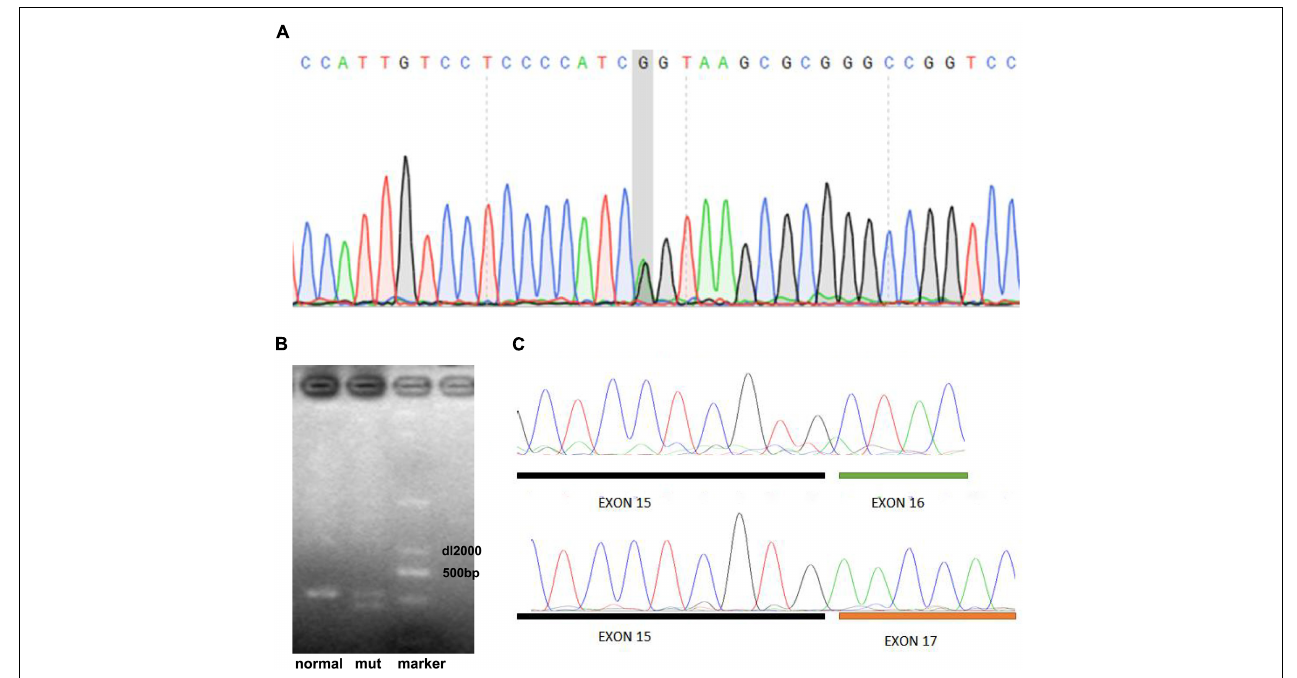
FIGURE 2 | Identification of genomic variant in LDLR of proband. (A) DNA sequencing showed a single-base substitution (G < A) at position 2389 in 16th exon of LDLR gene. (B) RT-PCR including 16th exon showed that proband had an additional PCR product of a different length from one PCR product obtained for healthy control. (C) Sequencing results showed that shorter PCR product exclusively observed in proband had deletion of 16th exon of mutant LDLR